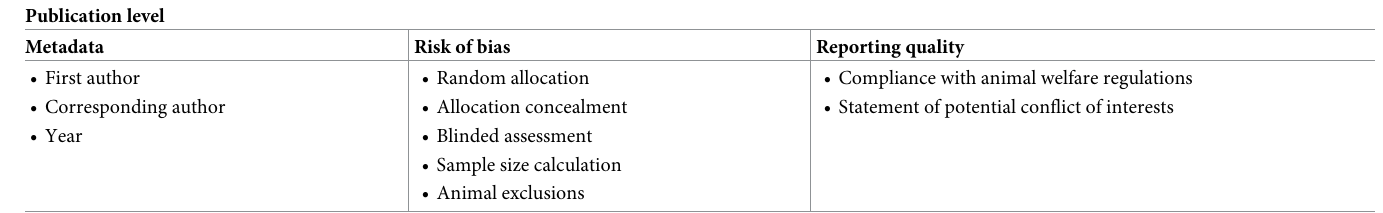
Table 5. Publication level data abstracted from each publication.